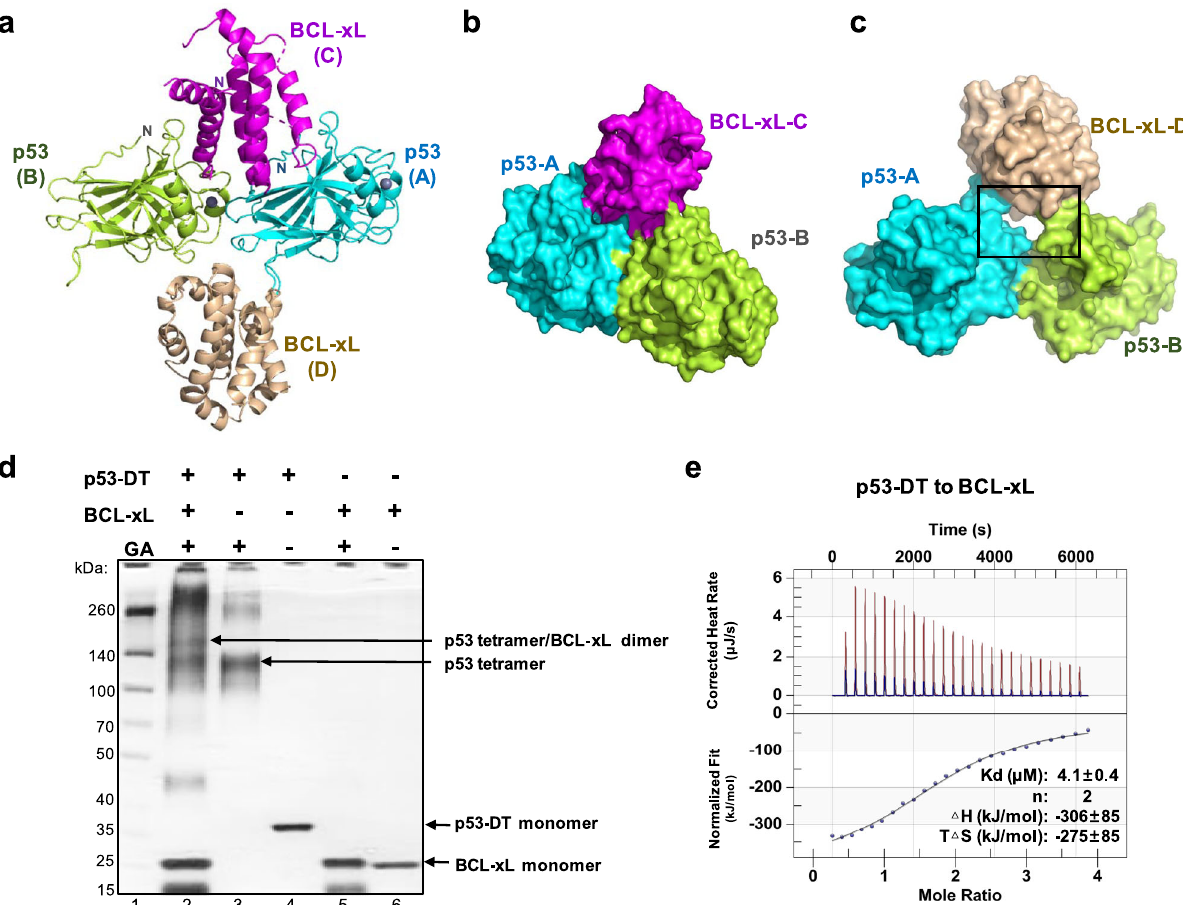
Fig. 1 The complex formation of p53 and BCL-xL. a Overall structure of p53/BCL-xL complex. An asymmetric unit of p53/BCL-xL complex comprises two p53-DBD molecules (colored cyan and limon) and two BCL-xL molecules (colored magenta and wheat). b A surface model of the ternary complex composed of the p53 dimer and BCL-xL-C. BCL-xL-C molecule inserted deep into the groove formed by the p53 dimer. c A surface model of the ternary complex composed of the p53 dimer and BCL-xL-D. BCL-xL-D molecule sits outside the groove formed by the p53 dimer. d The complex formation of p53- DT and BCL-xL analyzed by protein crosslinking and SDS-PAGE. Puri fi ed p53-DT, BCL-xL or their mixture were incubated in the presence or absence of 0.1% glutaraldehyde (GA) as indicated. Products of the crosslinking reactions were analyzed by SDS-PAGE followed by silver staining. The experiments were repeated independently more than 3 times with similar results and a representative experiment is shown. e The binding af fi nity between p53-DT and BCL-xL was measured using isothermal titration calorimetry (ITC) assays. The binding parameters indicate average of three independent titrations ± SEM. Source data are provided as a Source Data fi